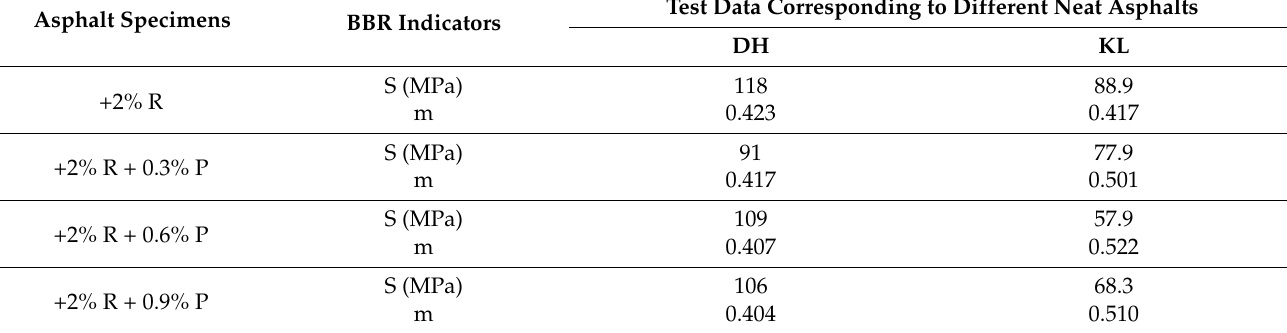
Table 5. BBR test results of PPA/SBR-modified